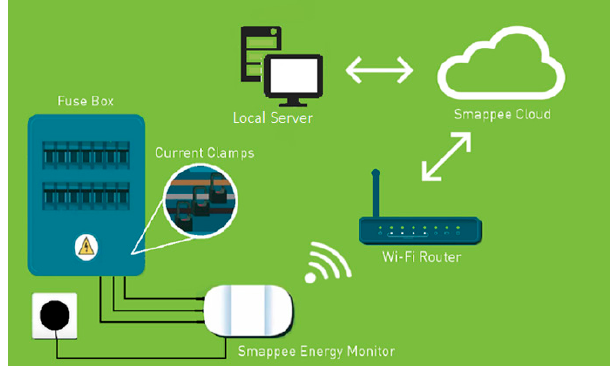
Figure 2. Power monitoring system structure.